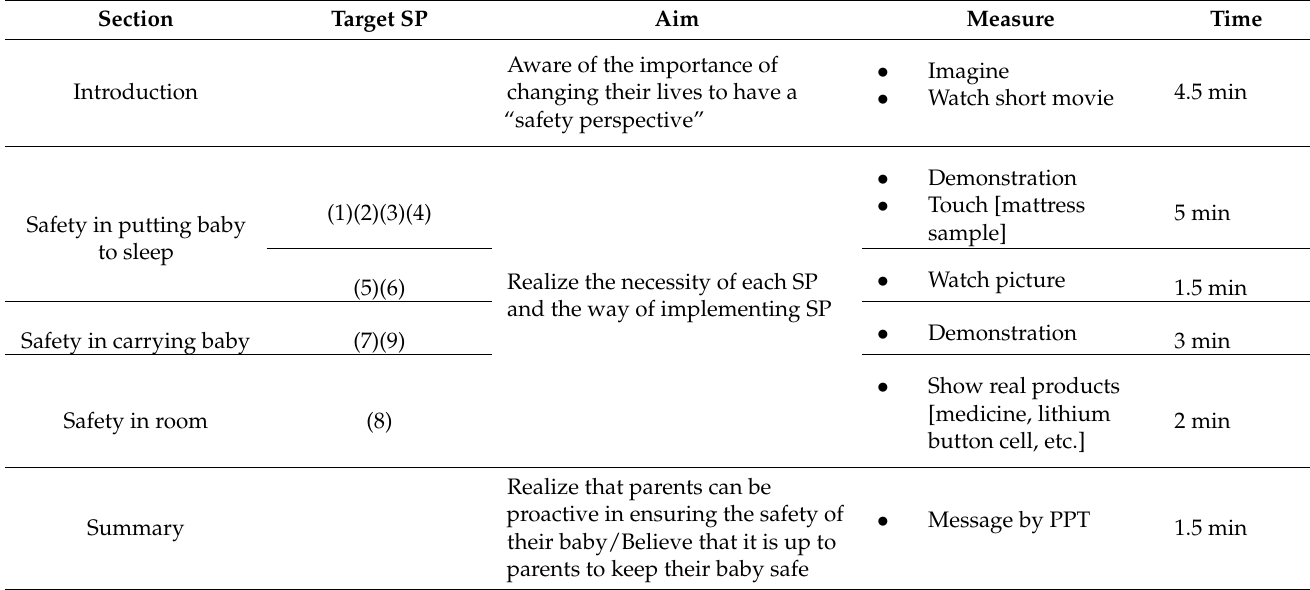
Table 2. Overview of educational program in the intervention